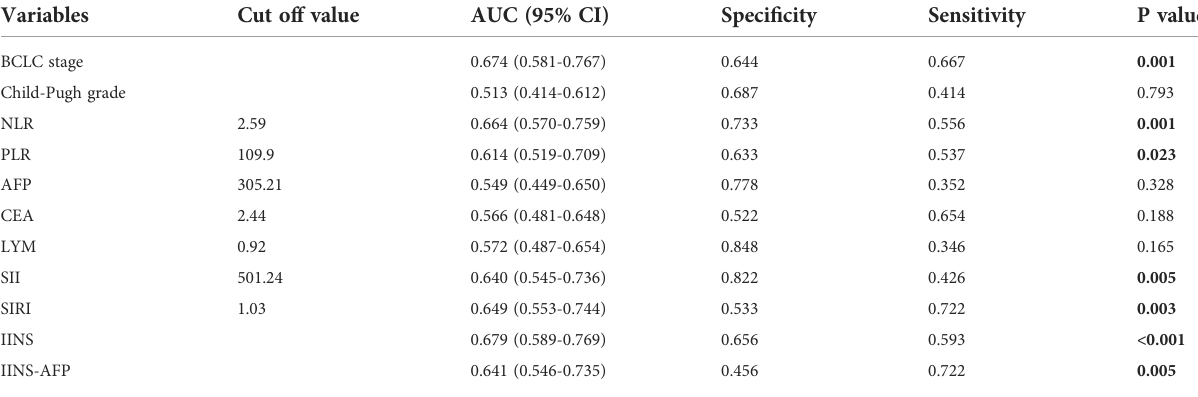
HCC, hepatocellular carcinoma; BCLC, Barcelona Clinic Liver Cancer; AFP, alpha-fetoprotein; CEA, carcinoembryonic antigen; LYM, lymphocyte; NLR, neutrophil – lymphocyte ratio; PLR, platelet – lymphocyte ratio; SII, systemic immune-in fl ammation index; SIRI, systemic in fl ammation response index; IINS, in fl ammation-immunity-nutrition score. Bold values means the P value is signi fi cant.